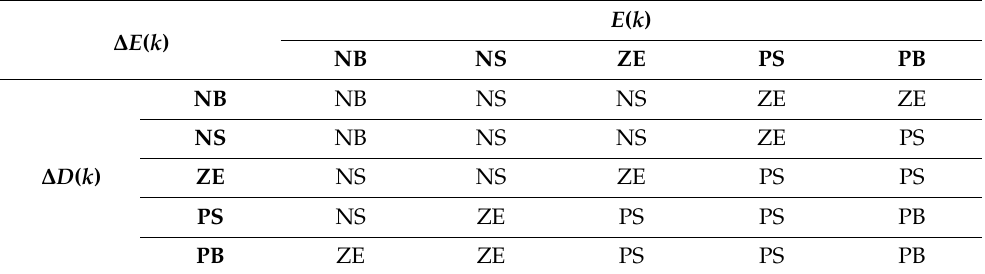
Figure 17. Input ( a , b ) and output ( c ) Membership Functions of F-LC for PEM-FC System. Table 9. Rule Base for F-LC MPPT for PEM-FC System. Table 9. Rule Base for F-LC MPPT for PEM-FC System.